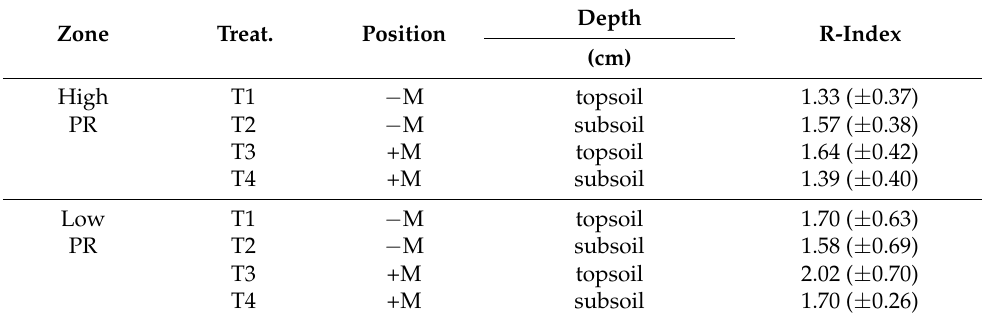
Table 4. Repellency index (R, dimensionless) obtained by the method proposed by Tillman, et al. [27] in air-dried